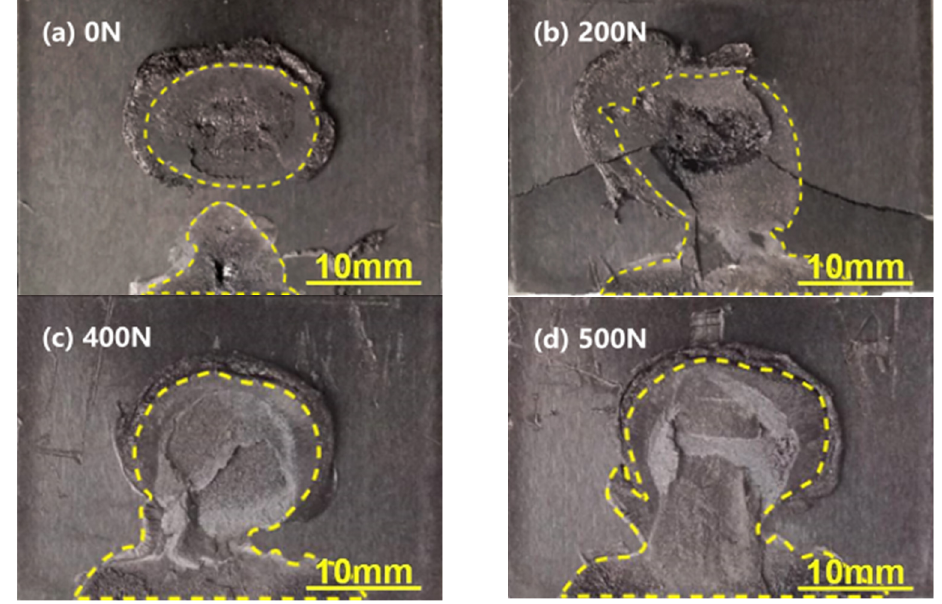
Figure 10. Effect of preload on the weld nugget size of joints with a gap of 1.5 mm.